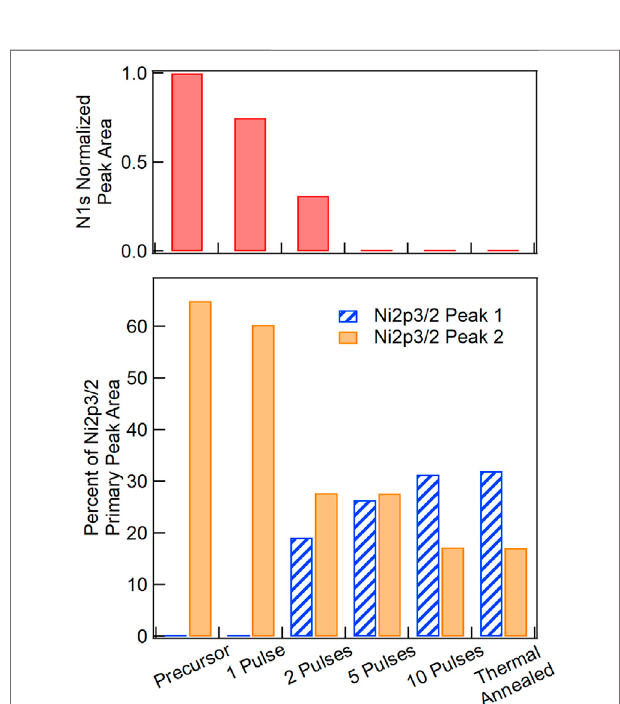
FIGURE5| XPSN1s(top)andNi2p 3/2 (bottom)peakareasforNiO x fi lms photoniccuredwithvaryingnumberofpulsesandaNiO x fi lmthermallyannealed forreference.N1speakareasarenormalizedtothatoftheprecursorsample.Ni 2p 3/2 peak 1 (blue, hashed bars) and peak 2 (orange, solid bars) are expressed as a percentage of the total Ni 2p 3/2 primary peak area. Peak 1 is attributed to NiO only and peak 2 is attributed to several Ni hydroxide species. Full Ni 2p 3/2 spectra are shown in Supplementary Figure S4.